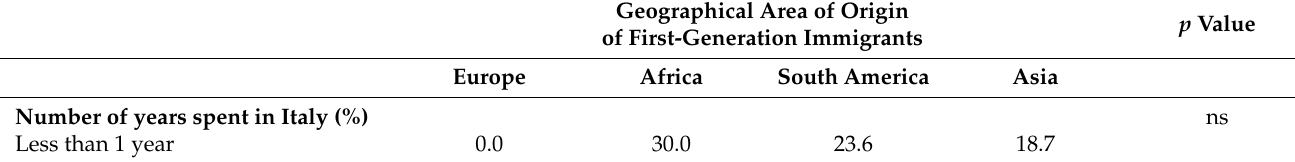
Table 3. Number of years spent in Italy and linguistic competences in the Italian language of first-generation immigrants by geographical area of origin. Geographical Area of